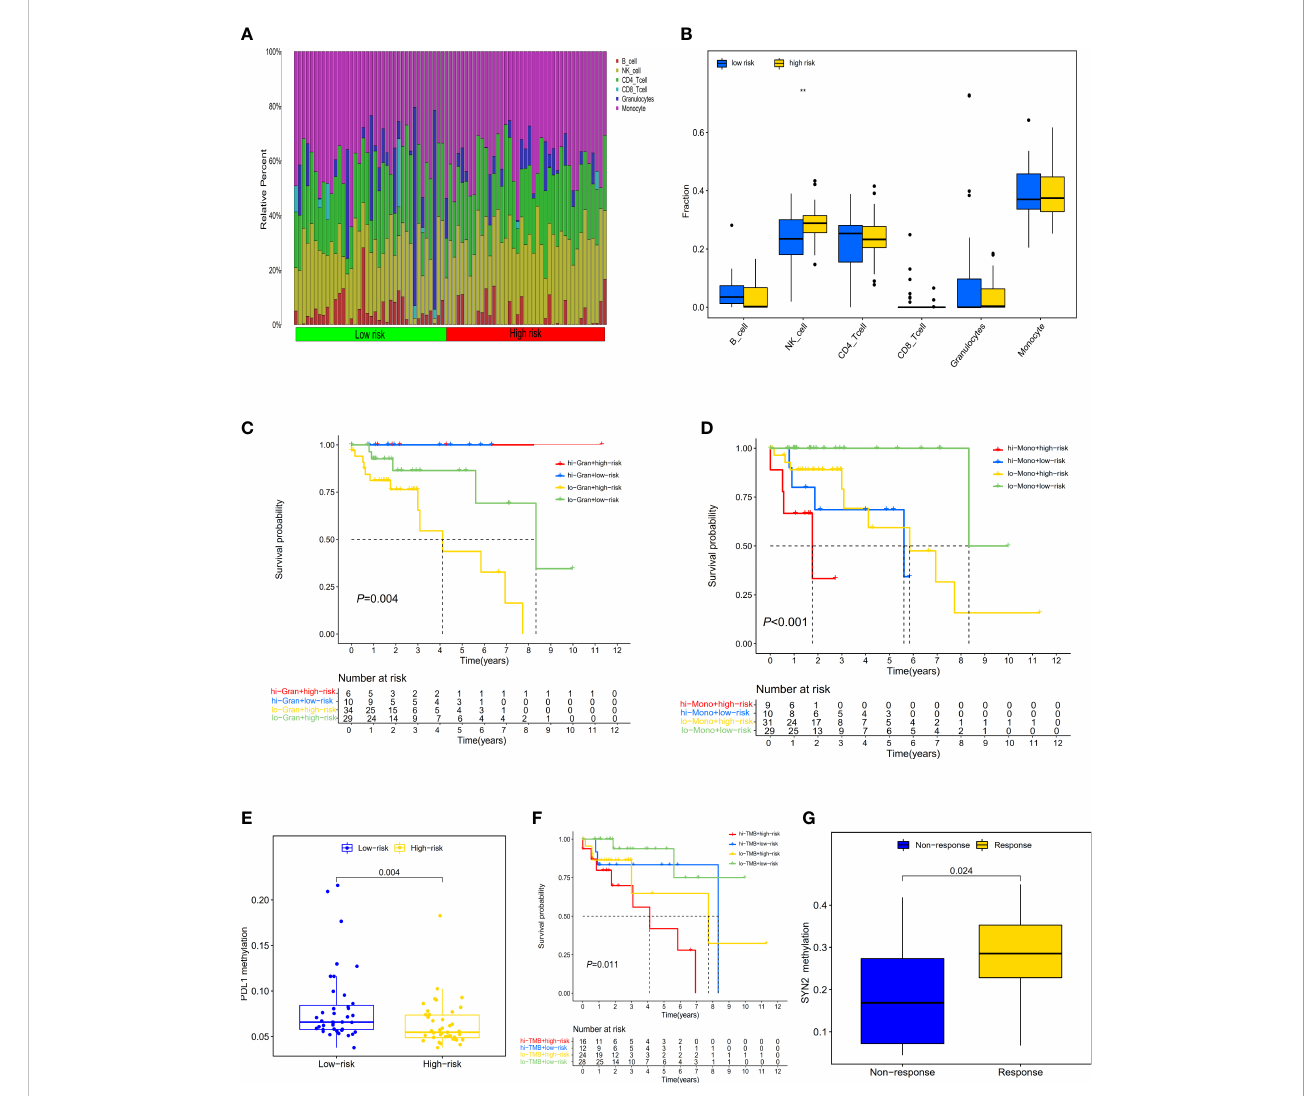
FIGURE 5 Distribution and characteristics of immune cells in fi ltration and the prognostic value of risk score in patients with ICI therapy. (A) The composition of tumor immune cells in fi ltration in every high- and low-risk sample. (B) Differences in six type of in fi ltration cells between the two groups of samples (** P < 0.01. (C) The survival of patients with high (low) risk and high (low) in fi ltrating granulocytes levels. (D) The survival of patients with high (low) risk and high (low) in fi ltrating monocyte levels. (E) Differences in PD-L1 methylation between high- and low-risk score subgroups. (F) The survival of patients with high (low) risk and high (low) TMB. (G) Differences in SYN2 methylation between distinct immunotherapy clinical response